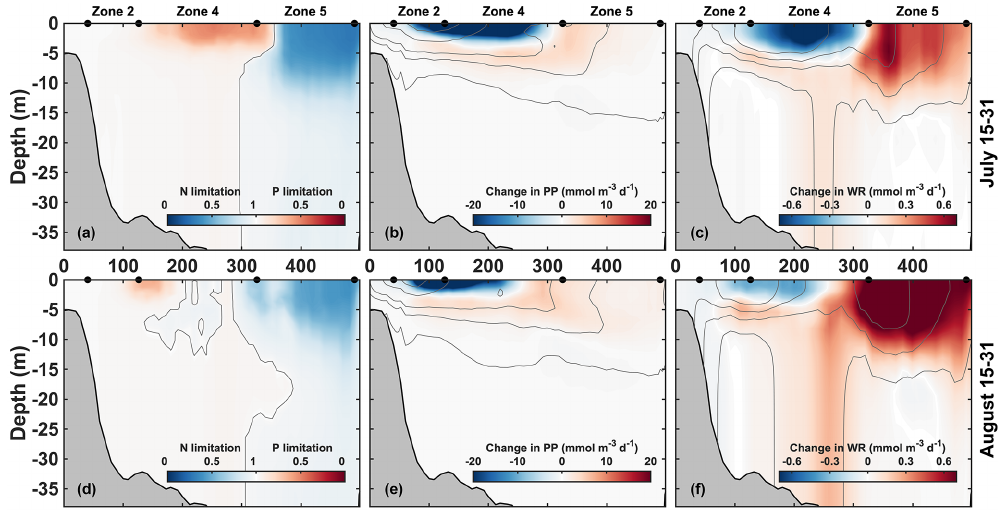
Figure 6. Mean vertical transects along the CE–JI line (see Fig. 1) for 15–31 July (a–c) and 15–31 August (d–f) . Left panels (a, d) : nutrient limitation factors. The color represents the most limiting nutrient at each location and depth, either N (blue) or P (red). Central and right panels: change in primary production (b, e) and water column respiration (c, f) due to P limitation (baseline – NoPlim). Thin grey lines represent the no limitation isoline in panels (a) and (d) (limitation factor = 1) and are indicative of PP and WR contours in panels (b) and (e) and panels (c) and (f) , respectively. The x axis is in kilometers from the CE along the CE–JI